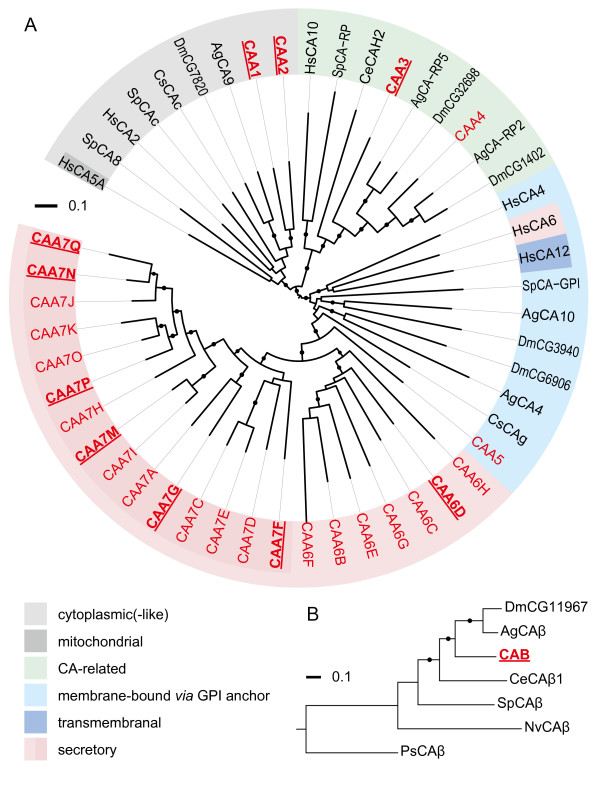
Classification of CA-like amino acid sequences from Daphnia pulex. Phylogenetic trees for selected α-carbonic anhydrases (α-CAs) (A) and β-CAs (B) based on multiple-sequence alignments (Additional files 1 and 2). D. pulex sequences are shown in red; underlined labels indicate EST support. Three fragmentary sequences (CAA6A, CAA7B, CAA7L; Table 4) from D. pulex were excluded from the alignment. Additionally included were related sequences from the blue crab Callinectes sapidus (Cs), Drosophila melanogaster (Dm), Anopheles gambiae (Ag), Caenorhabditis elegans (Ce), sea urchin Strongylocentrotus purpuratus (Sp), Homo sapiens (Hs), the sea anemone Nematostella vectensis (Nv), and Pisum sativum (Ps). α-CAs were classified in terms of their putative destination into mitochondrial and cytoplasmic, CA-related, membrane-bound and transmembrane, and secretory proteins. CA-related proteins have lost most of the highly conserved active-site residues. Membrane-associated α-CAs have a C-terminal attachment signal for a glycosylphosphatidylinositol (GPI) anchor which tethers the extracellular protein to the cell membrane [123]. The trees were constructed using the neighbor-joining algorithm. Bootstrap analysis was performed with 1000 replicates (bootstrap values > 800 are indicated by filled circles). For sequence references, see Additional files 1 and 2.